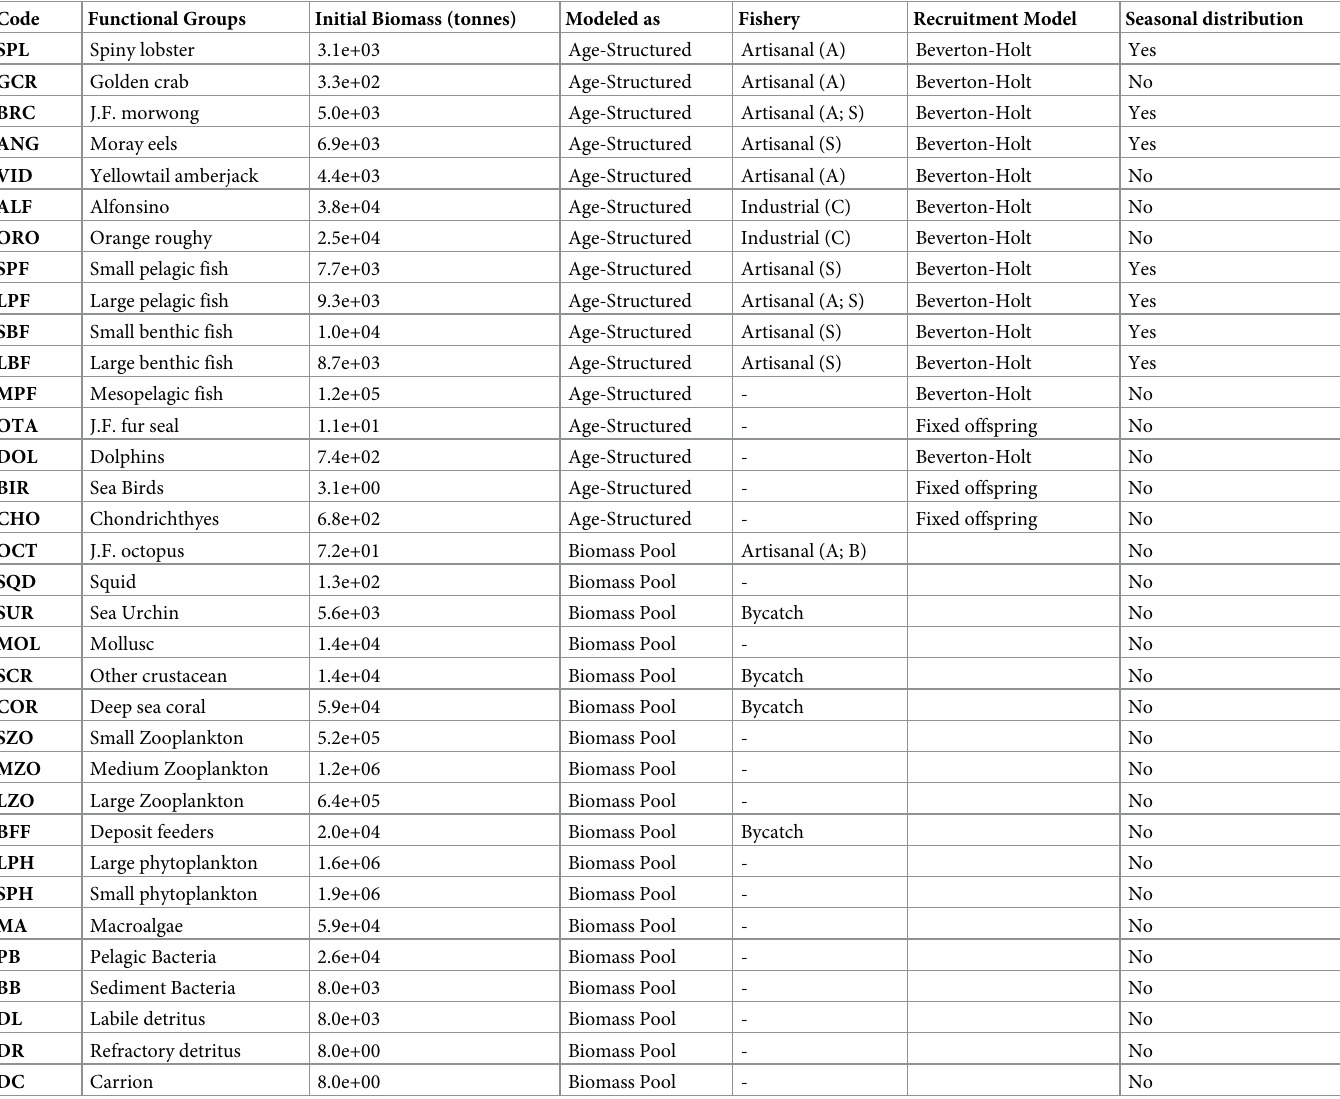
Table 1. Biological functional groups in the JFRE model and their main configuration. The initial biomass in metrics tonnes, the classification ( A ) under fisheries means active fishery, ( S ) means secondary fishery or bait fishery, ( C ) represents currently closed fisheries and ( B ) was used for species that are bycatch of other fisheries (J. F. abbreviation stand for Juan Ferna´ndez). More detailed descriptions of the functional groups can be found in the supplementary